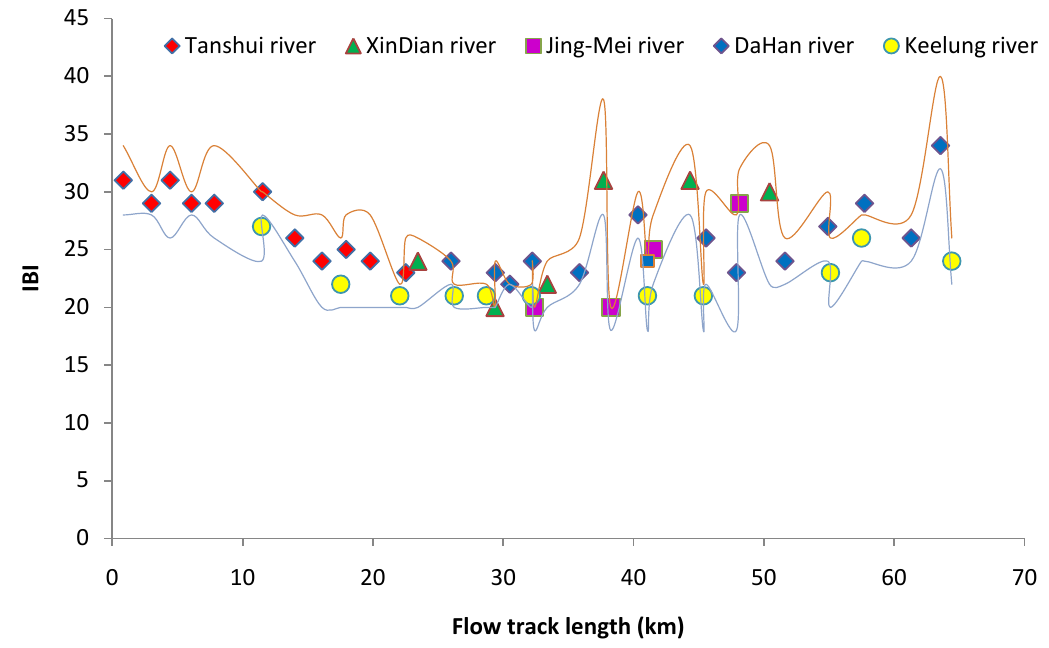
Figure 8. The IBI value for the fish community of the Tanshui River basin in 2012. The point marks indicate the mean of four seasons, red line was upper limit and black line was lower